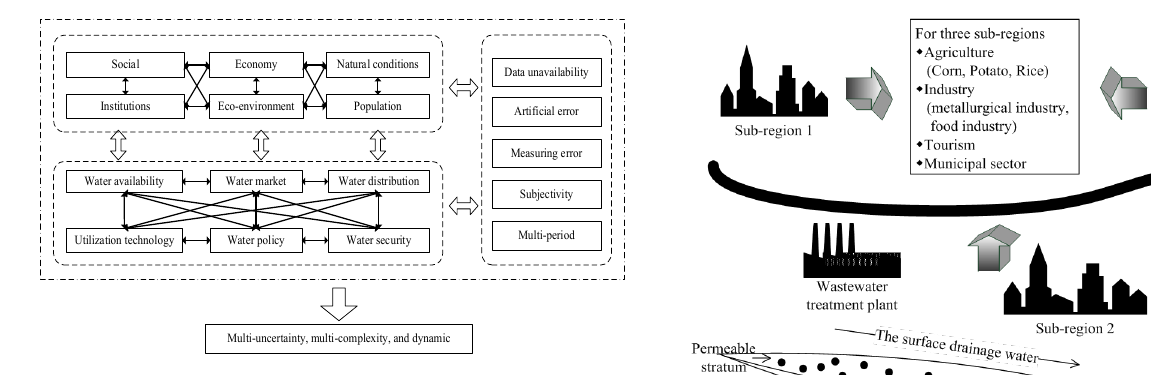
Fig. 2. Water and farmland use management system.